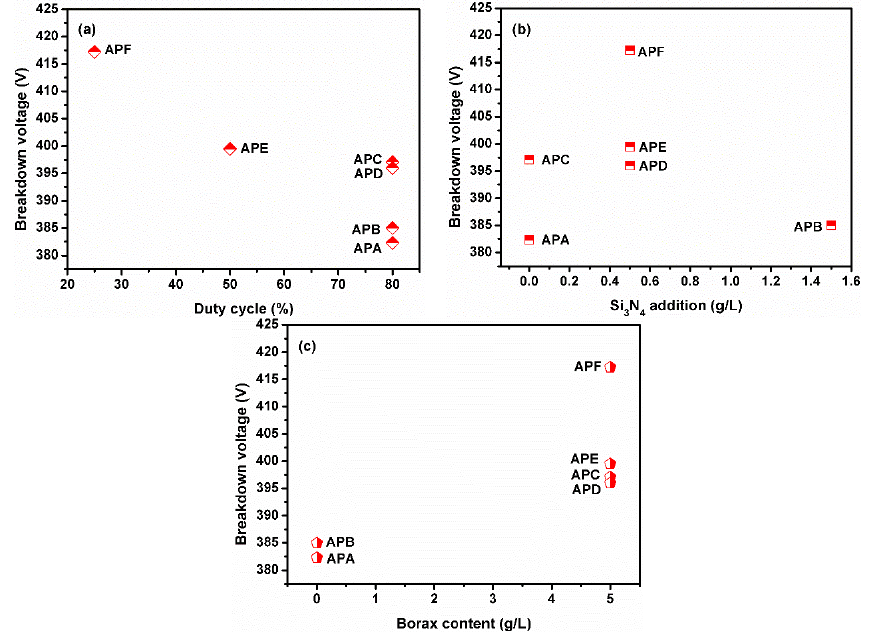
Figure 3. The relationships between breakdown voltage and ( a ) duty cycle, ( b ) Si 3 N 4 and ( c ) borax